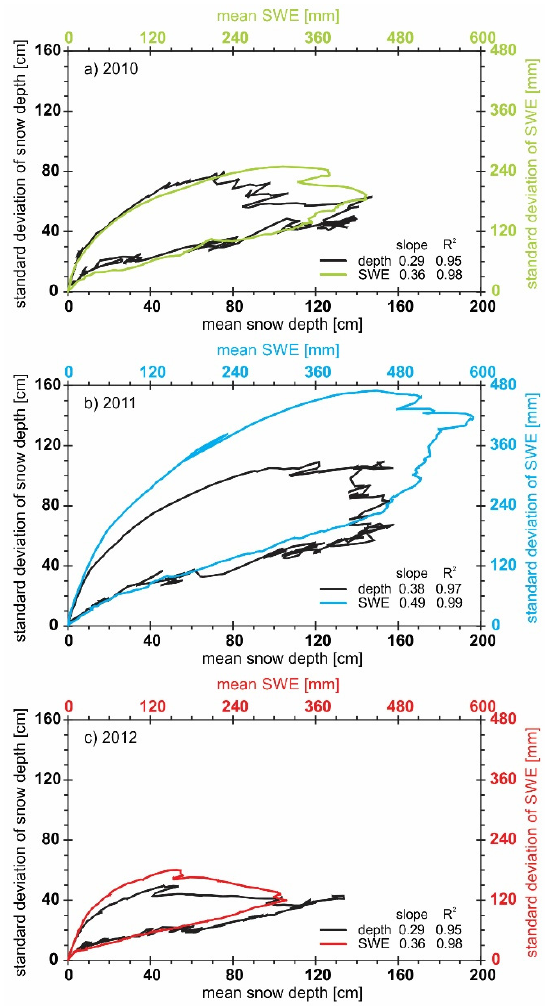
Figure 4. Mean and standard deviation of mean daily data for snow depth (87 SNOTEL stations) and SWE (90 SNOTEL stations) for ( a ) 2010 (average snow year), ( b ) 2011 (above average snow year) and ( c ) 2012 (below average snow year). The slope and R2 values listed in the lower right of each figure are for the accumulation phase.